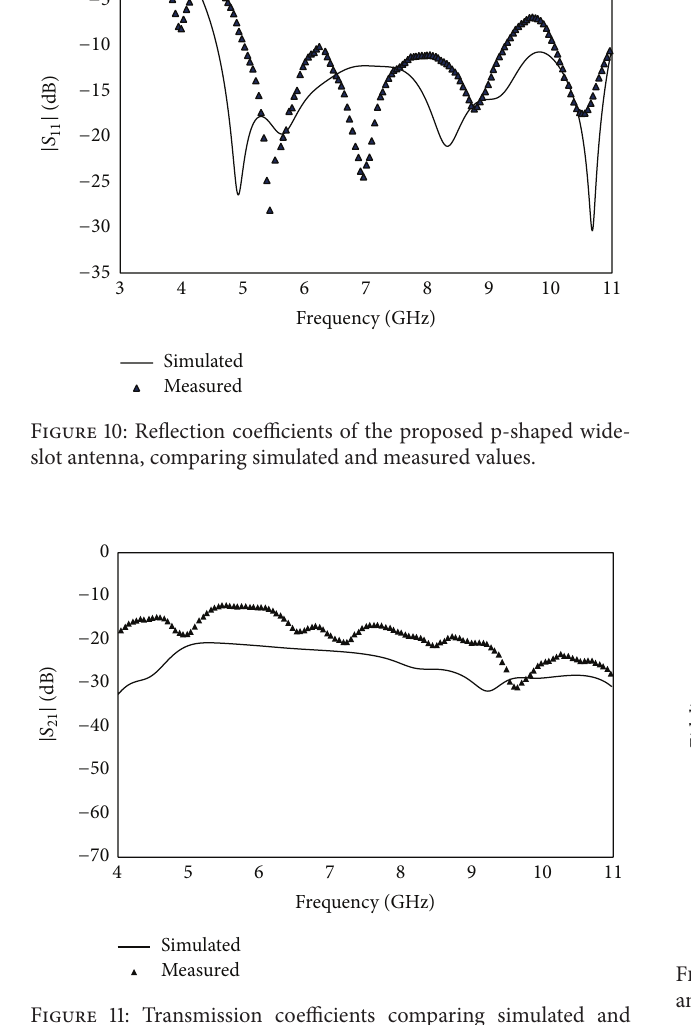
Figure 11: Transmission coefficients comparing simulated and measured values.